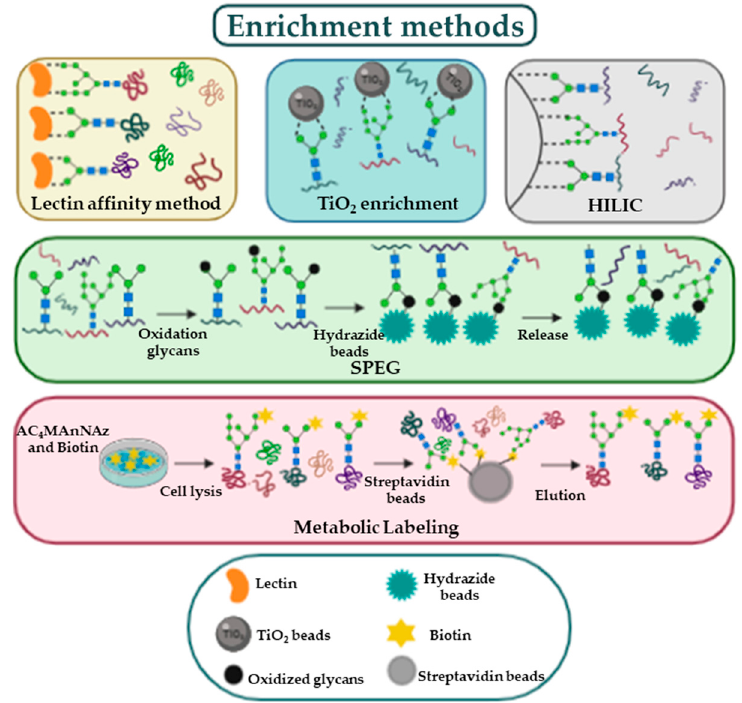
Figure 1. Bottom-up approach.